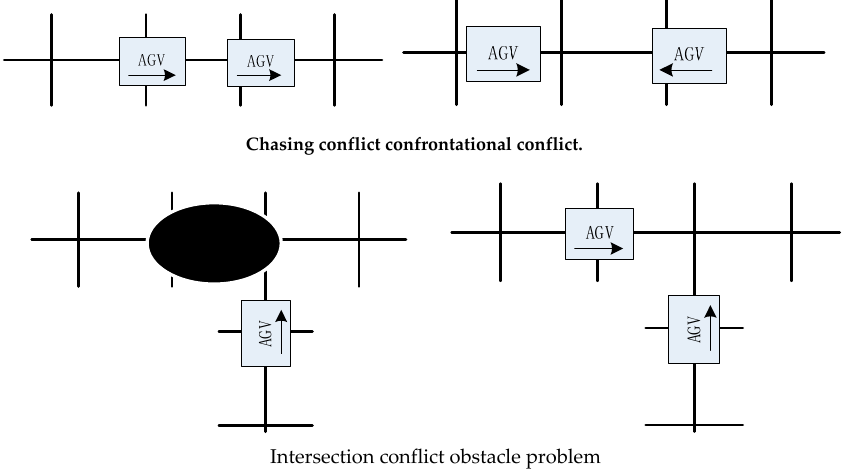
Figure 6. Common problems of AGV operation.